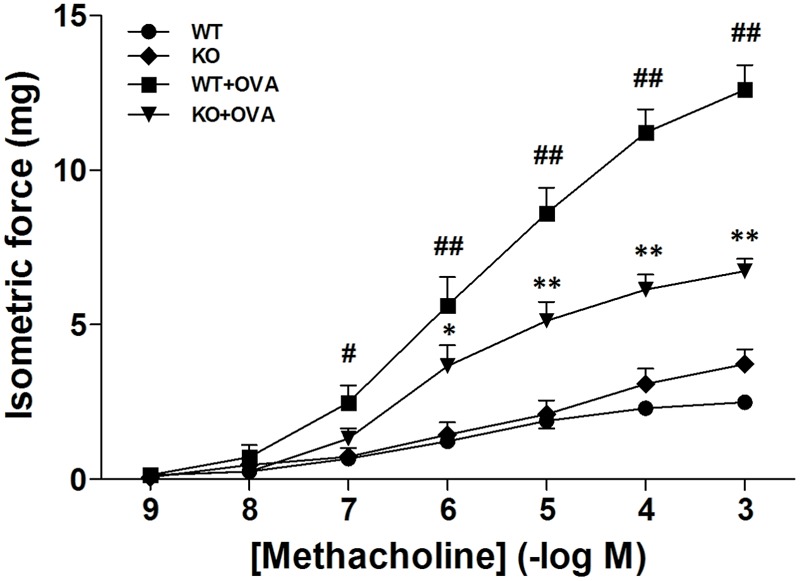
Gene deletion of KCa3.1 reduced established OVA-induced changes in constrictor responsiveness to methacholine in mouse bronchi. Relative to WT group bronchi, maximal isometric contractile force responses to methacholine were significantly increased in WT + OVA group bronchi, and this increased constrictor responsiveness to methacholine was prevented in KO + OVA group bronchi tissues. Data represented means ± SEM (n = 4–6). #p < 0.05, ##p < 0.01 versus WT mice. ∗p < 0.05, ∗∗p < 0.01, two-way ANOVA followed by the Bonferroni multiple comparison test compared with WT + OVA group mice. WT, wildtype; KO, knockout.